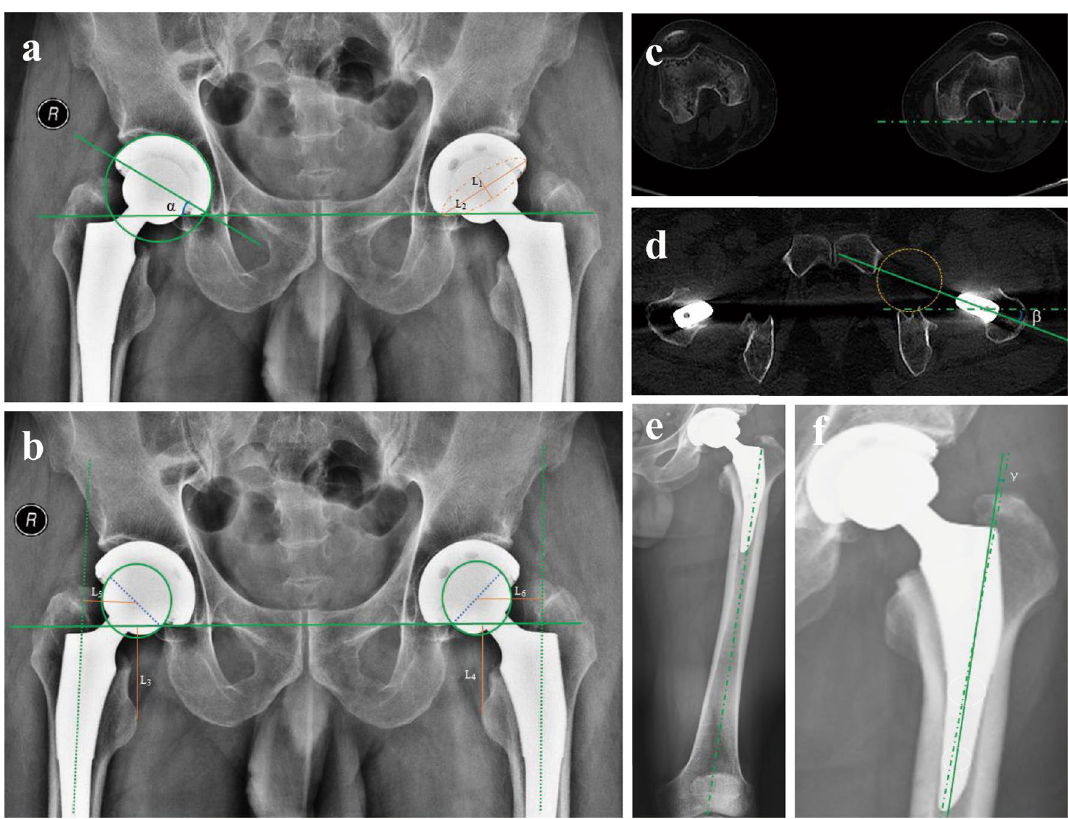
Figure 2. Radiographic measurements. ( a ) The methods of measuring the acetabular inclination angle (α) and acetabular anteversion angle on an AP radiograph, the long and short axes of the ellipse are used to calculate the acetabular anteversion angle, which is arcsin (L1/L2). ( b ) A line was drawn perpendicular to the inter-teardrop line and passed through the tip of the lesser trochanter on both sides (L3, L4). LLD was defined as the difference in distance between L3 and L4. Femoral offset was defined as the distance from the femoral head center to a line bisecting the long axis of the femur (L5, L6). ( c, d ) Femoral stem anteversion was defined as the angle (β) between the axis of the stem-neck and the posterior condylar axis of the femur. ( e, f ) Stem varus/valgus was measured as the angle (γ) between the anatomic axis of the femur and the axis of the femoral stem in the coronal plane. AP, anteroposterior; LLD, leg length